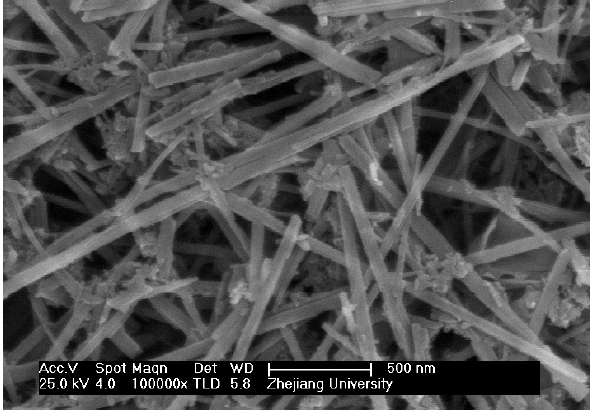
Figure 1. SEM image of the ZnO-modified MnO